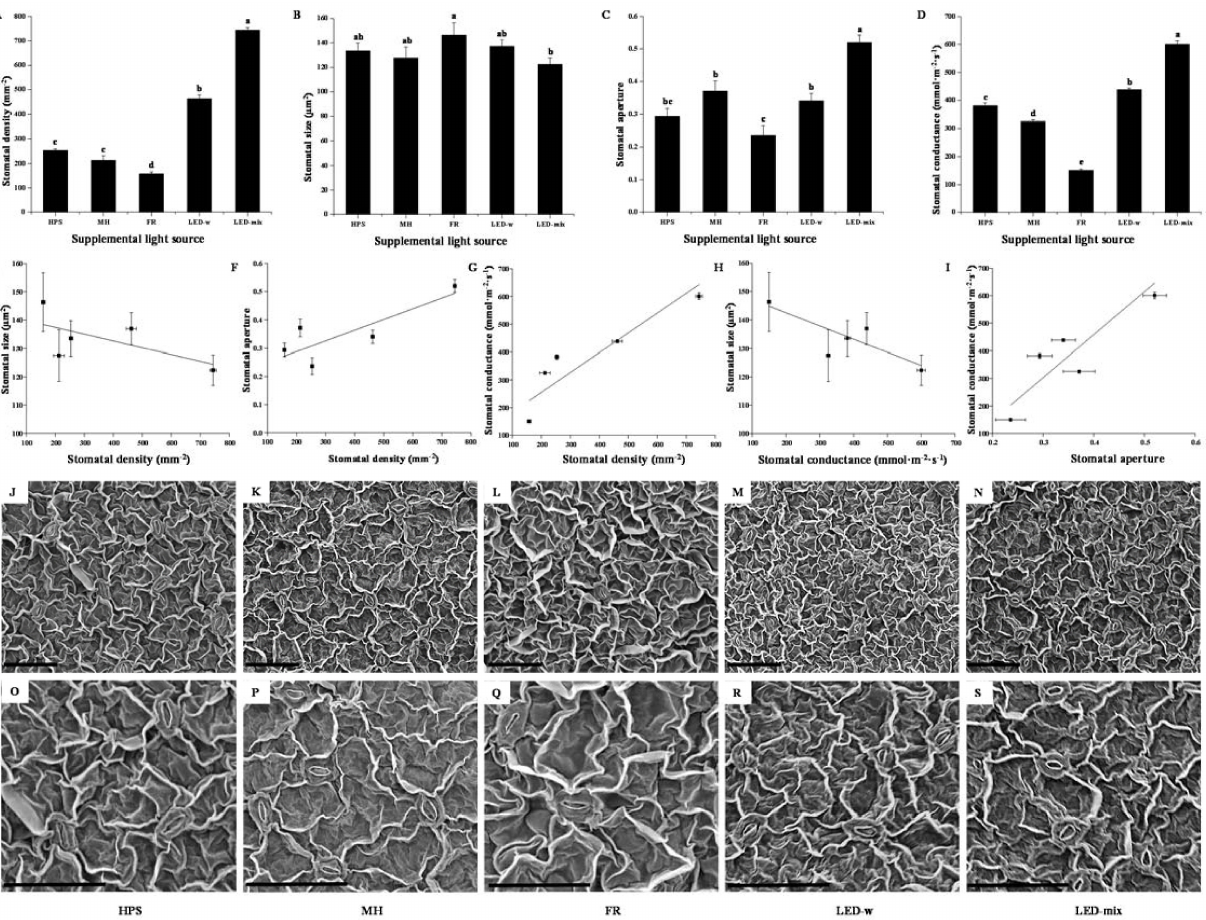
Figure 3. Stomatal density ( A ), stomatal size ( B ), stomatal aperture ( C ), stomatal conductance ( D ), relationships between the stomatal properties ( E – I ), and stomatal micrographs ( J – S ) of C. lanceolata seedling leaves observed by a scanning electron microscope. Scale bar, 50 µ m. Different small letters indicate the significant separation within treatments by Duncan’s multiple range test at a 0.05